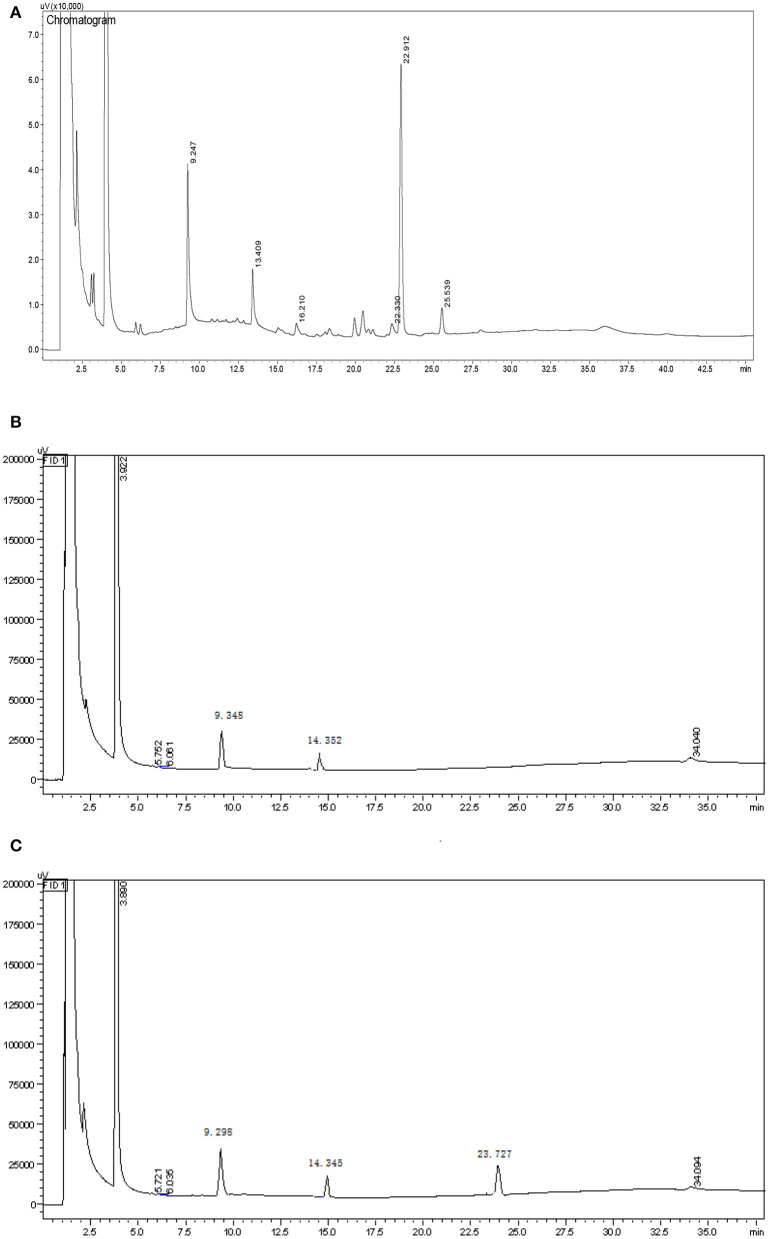
GC chromatogram of the Smith reaction products of HEBG-1 (A), HEBG-2 (B), and HEBG-3 (C).